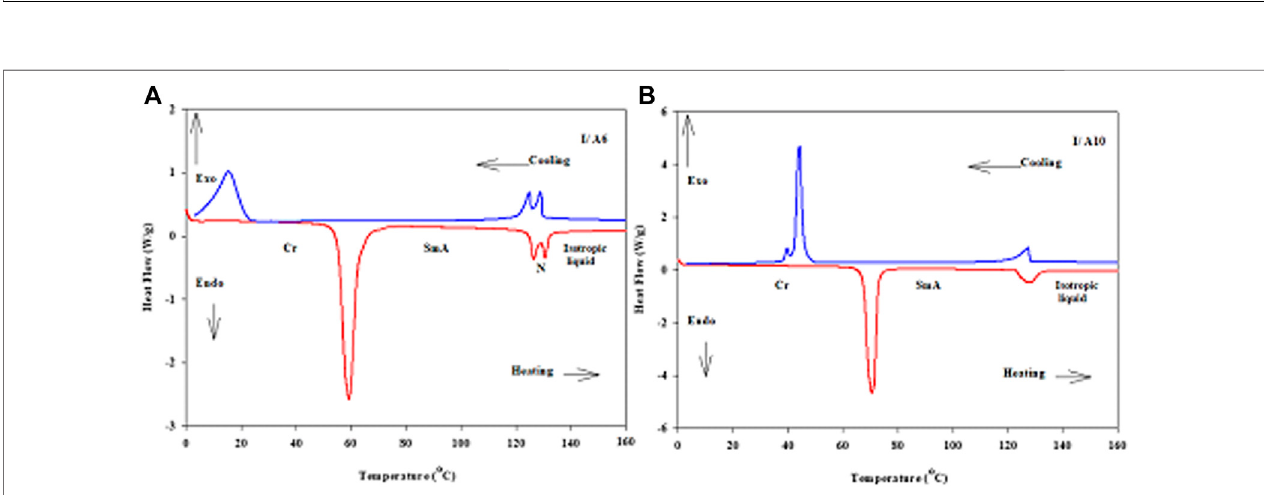
FIGURE 7 | DSC thermograms at a heating rate 10 o C/min for heating and cooling scans of 1:1 SMHBCs (A) I/A6 and (B) I/A10.